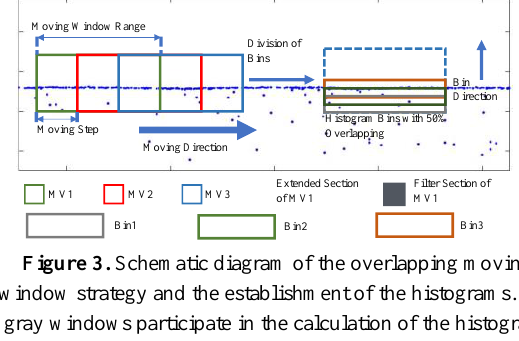
Figure 3. Schematic diagram of the overlapping moving window strategy and the establishment of the histograms. The gray windows participate in the calculation of the histogram, and only the signal photons in the red windows are recorded for the overlapping moving window strategy. Step2 : Overlapping Window Strategy Split Along